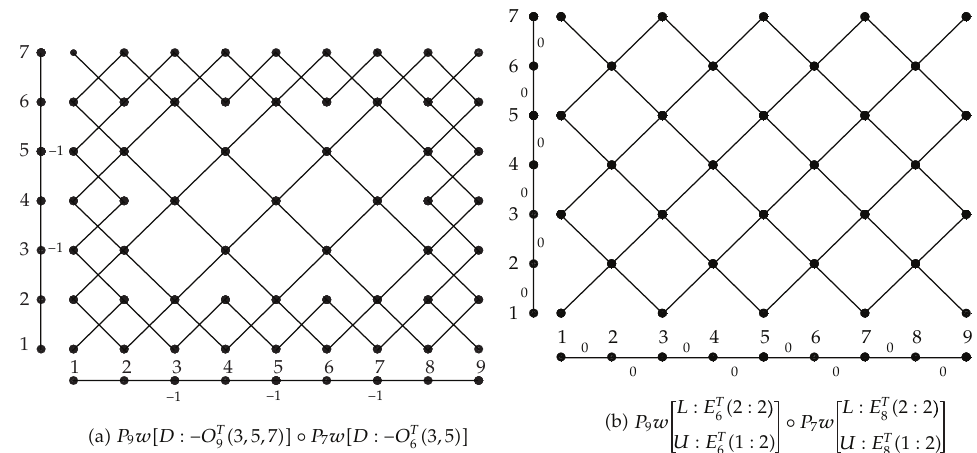
Figure 7: Examples of weighted direct products: product of P 7 w ◦ P 9 w .